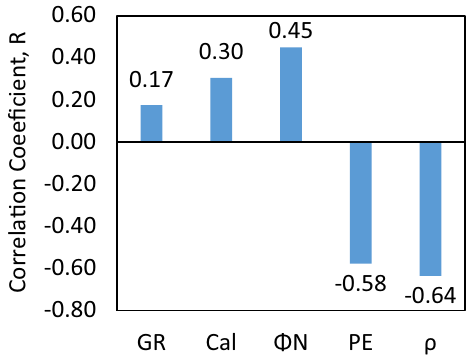
Figure 4. Relative importance of input parameters.